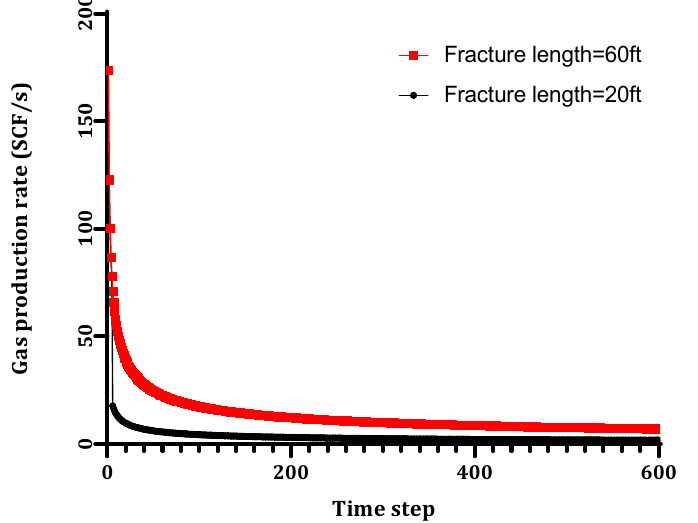
Figure 11. Comparison between production profiles for different fracture lengths. Since the amount of adsorbed gas depends on the gas density, a simulation run is performed under different gas densities of 5 and 25 lb/cf, respectively. The analysis in